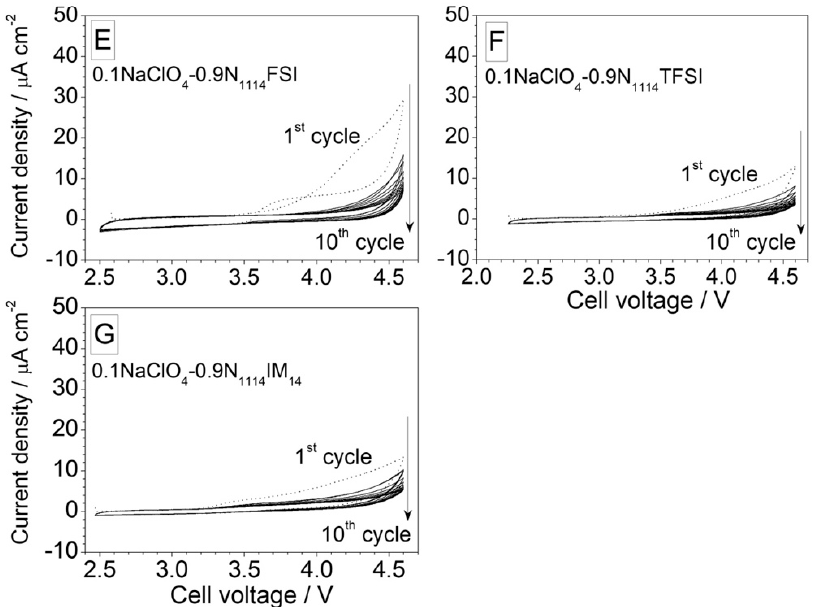
Figure 2. Current-voltage profiles obtained by anodic CV measurements run on Na/C cells containing different 0.1NaClO 4 -0.9IL electrolytes (panels from ( A – G )). Scan rate: 1 mV s –1 . Temperature: 20 ◦ C. The voltage values are referred to the Na + /Na ◦ redox couple. Table 2. Anodic voltage values (EA) determined by the CV measurements (reported in Figure 2) run on 0.1NaClO 4 -0.9IL electrolytes at 20 ◦ C. The voltage, referred to the Na + /Na ◦ redox couple, were taken when the current density through the cell reached 0.01 (EA 1 ) and 0.02 (EA 2 ) mA cm − 2 during the 1st and 2nd anodic scan, respectively. The error bar is equal to 0.001 V. Electrolyte